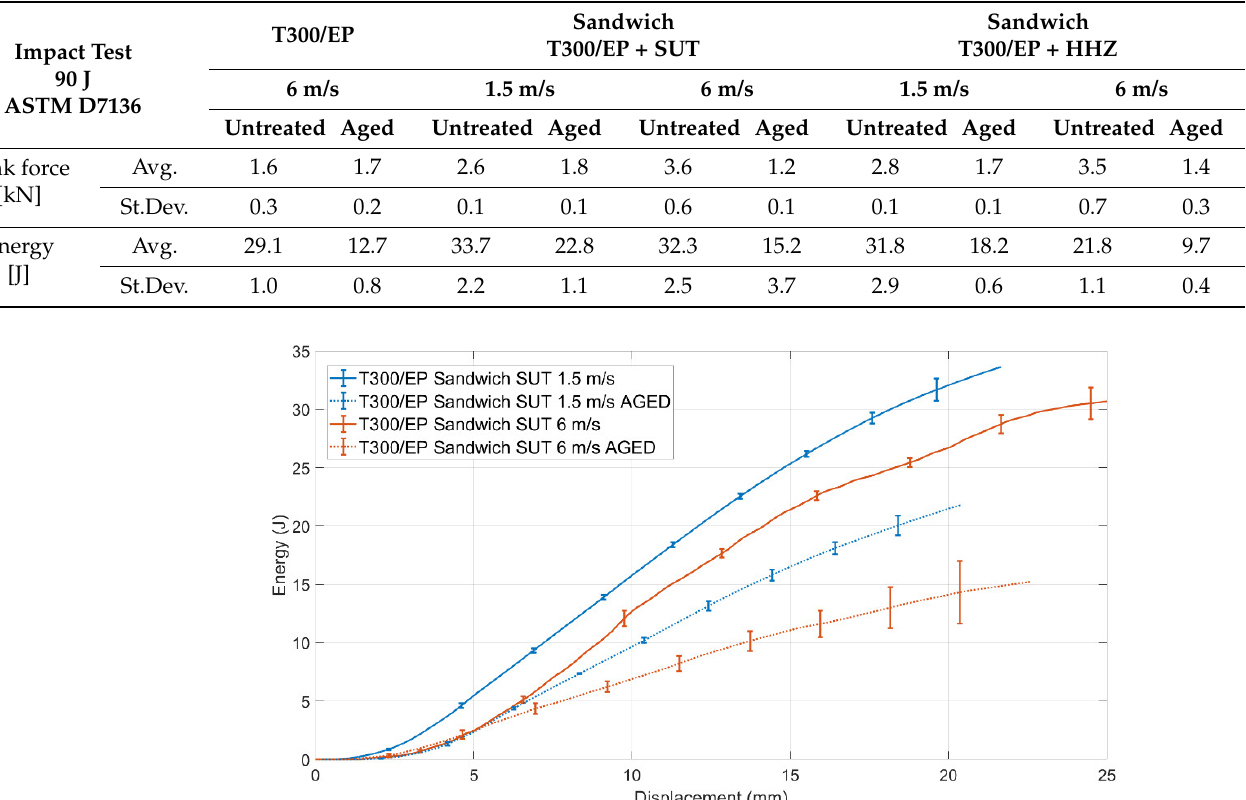
Table 4. Averaged results with the standard deviation of the impact tests.